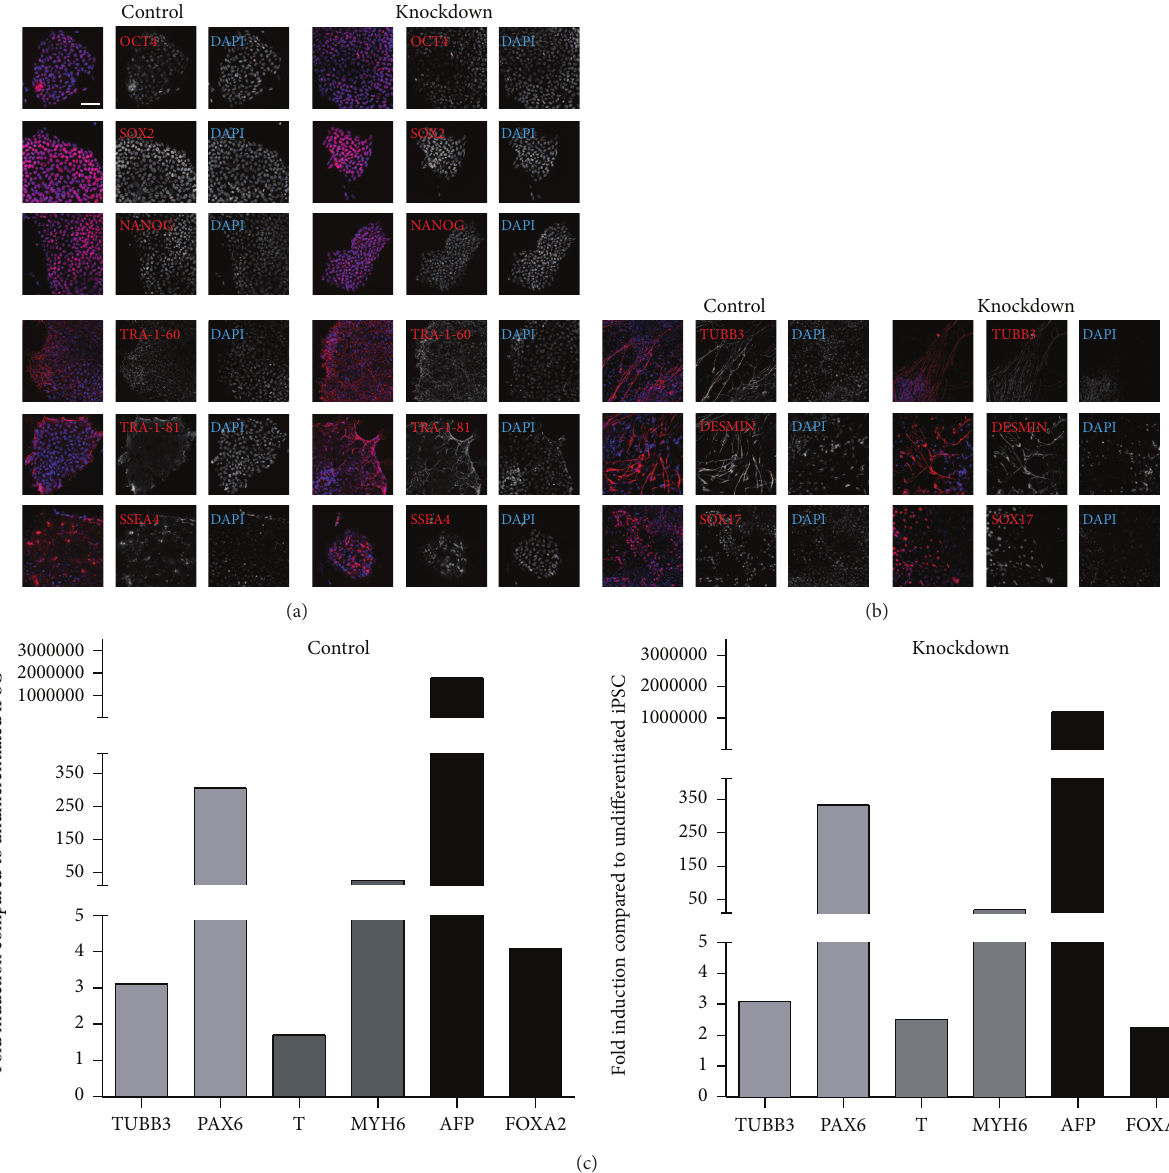
Figure 3: Reprogrammed fibroblasts under TBX3 knockdown have the same stem cell properties as control iPSCs. (a) Pluripotency staining of iPSCs generated from fibroblasts is positive for the pluripotency markers OCT4, SOX2, and NANOG as well as for the surface markers TRA-1-60, TRA-1-81, and SSEA4. (b) Immunocytochemistry of germ layer differentiation shows positive staining for ectoderm (TUBB3), mesoderm (DESMIN), and endoderm (SOX17) for TBX3 knockdown and control, respectively. (c) Expression of ectodermal genes ( TUBB3, PAX6 ), mesodermal genes ( T, MYH6 ), and endodermal genes ( AFP, FOXA2 ) in germ layer differentiation shows pluripotent differentiation potential of the generated iPSCs in both control and TBX3 knockdown cells. Scale bar: 100 𝜇